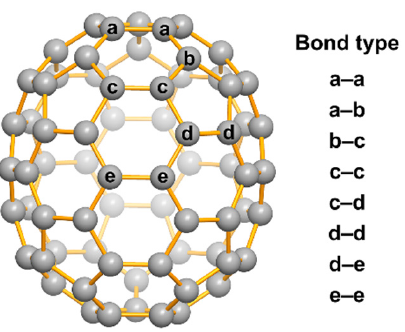
Figure 1. The five unequal types of carbon atoms ( a , b , c , d , and e ) and eight nonequivalent types of C–C bonds in C 70 .